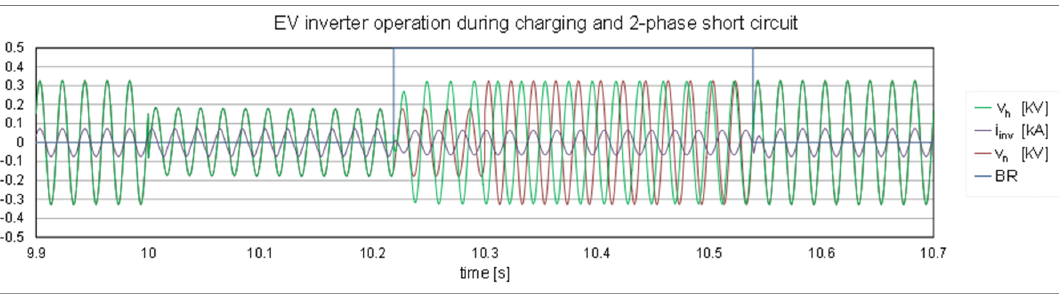
Figure 8. Inverter voltage and current and the network voltage during charging, 1-phase short circuit, island operation and again charging. The BR signal equal “0” means that BR breaker is closed. 5. Conclusions The potential advantages of the V2H services using the off-board inverters are well described in the literature. The novelty of this paper is the reference to the applicable use of on-board 3-phase motor inverter and its control system for the both EV charging and ancillary services—V2H. Such an approach is beneficial since additional infrastructure costs are minimal. In this paper authors concentrated on creating the accurate test-bed in the PSCAD environment that can be utilized to: •